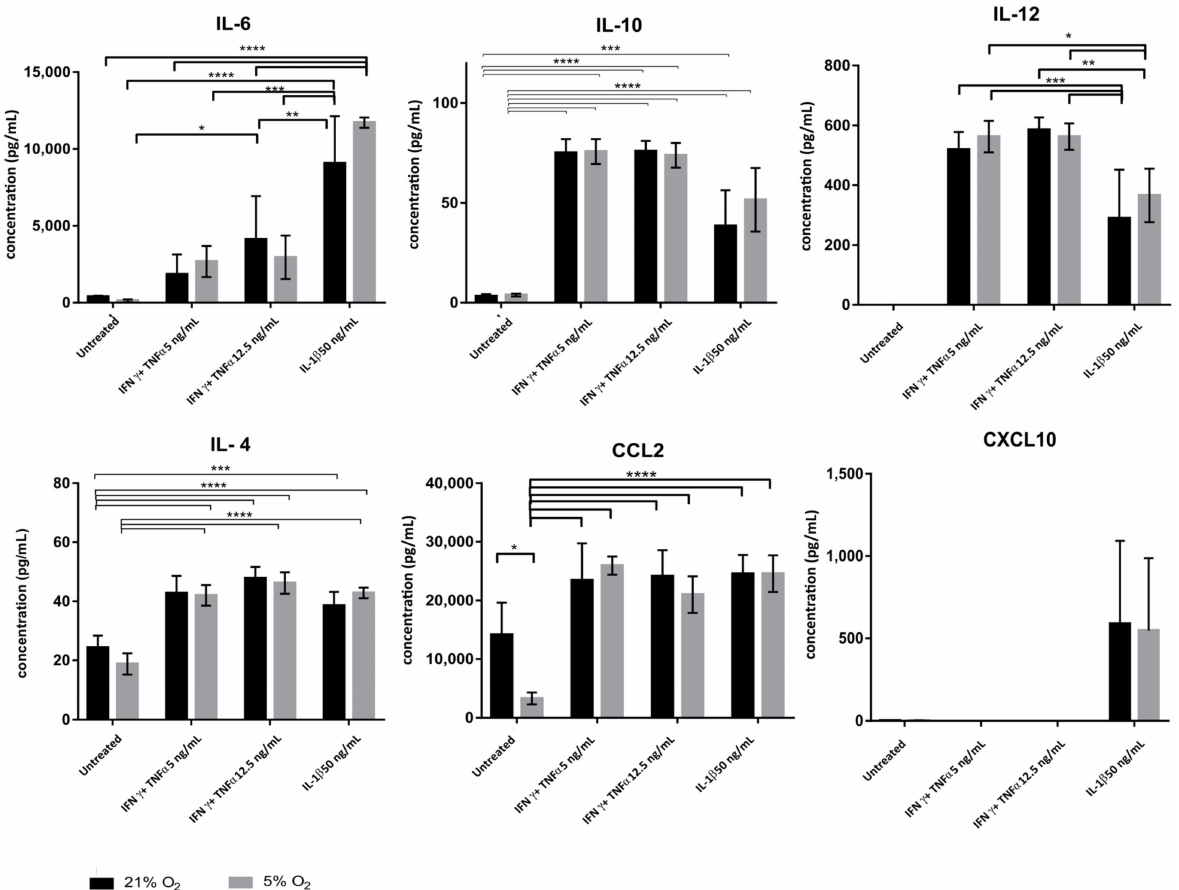
Figure 7. Quantitative analysis of cytokines secreted by WJ-MSCs cultured in 21% vs. 5% oxygen concentration after treatment with proinflammatory cytokines. Results are mean values (two-way ANOVA) for 3 independent experiments in min. 3 replicates ± SD; * p < 0.1, ** p < 0.01 *** p < 0.001, **** p <